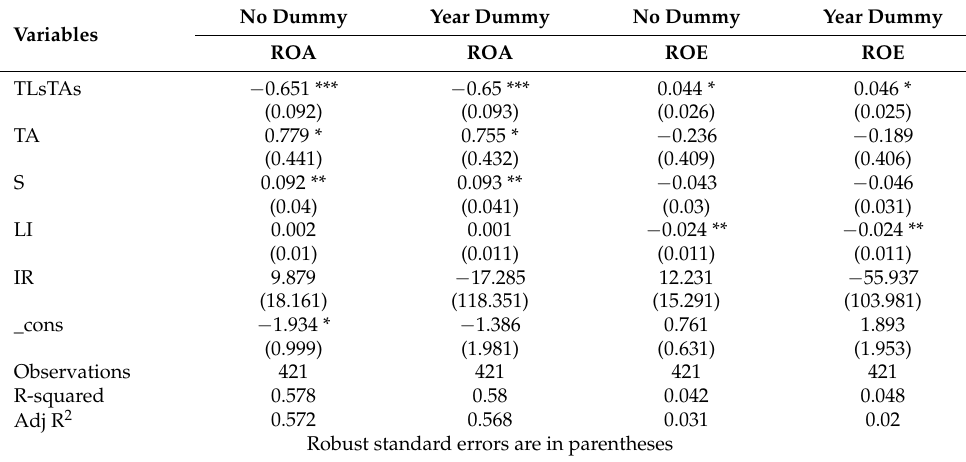
Table 6. Results of the Effects of TLsTAs on ROA and ROE, as per OLS Regression.